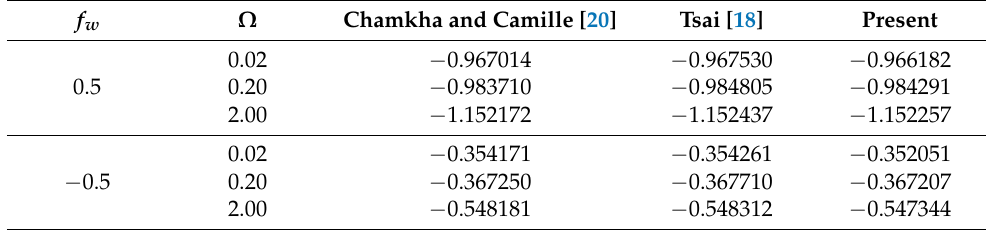
Table 1. Values of − φ (cid:48) ( 0 ) for values of Ω and f w with dropping micropolar factors. f w Ω Chamkha and Camille [20] Tsai [18] Present 0.02 − 0.967014 − 0.967530 − 0.966182 0.5 0.20 − 0.983710 − 0.984805 − 0.984291 2.00 − 1.152172 − 1.152437 − 1.152257 0.02 − − 0.5